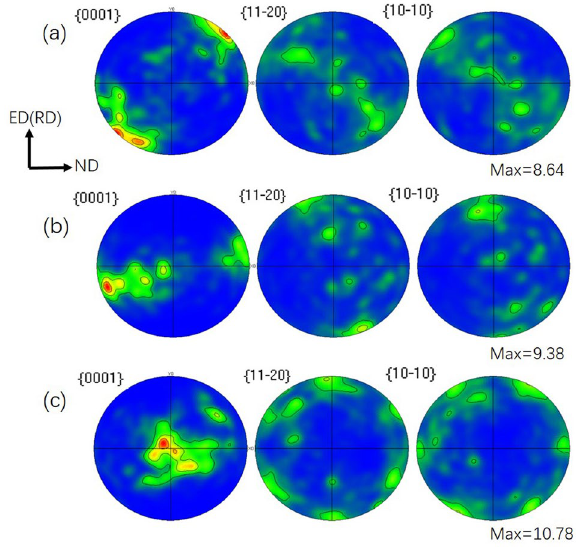
Figure 4. EBSD microscopic pole figure of the sample in different deformation states of Mg–2Y–0.6Nd–0.6Zr alloy. ( a ) ECAP4passes, ( b ) ECAP4Passes + rolling, ( c ) ECAP4Passes + liquid